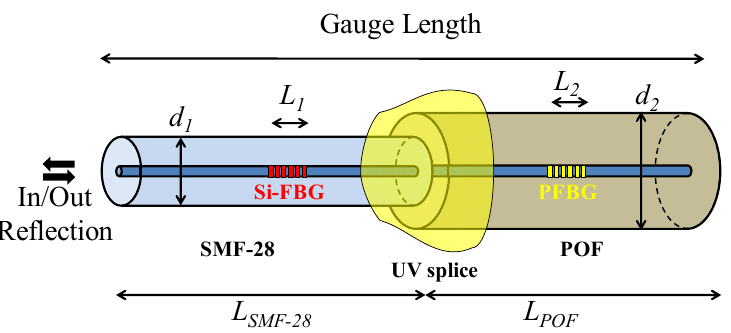
Figure 1. Schematic of the sensor, employing an FBG in a POF, in-series with a silica FBG by means of a UVsplice using a photopolymerizable adhesive. L i , and d i represent the length and diameter of the fibers, respectively.